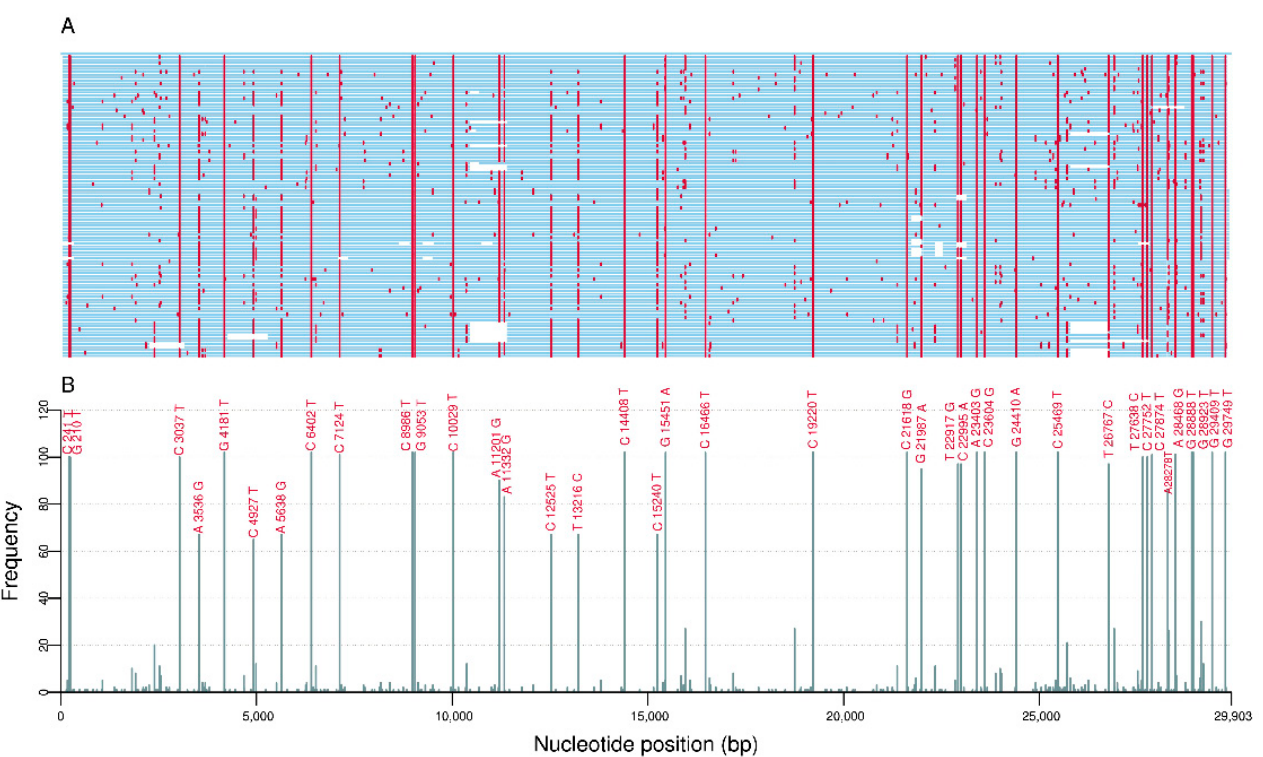
Figure 3. ( A ) Genomic location and ( B ) frequency of single-nucleotide polymorphisms (with respect to the reference genome NC_045512.2) among 102 sequences from VOC Delta.